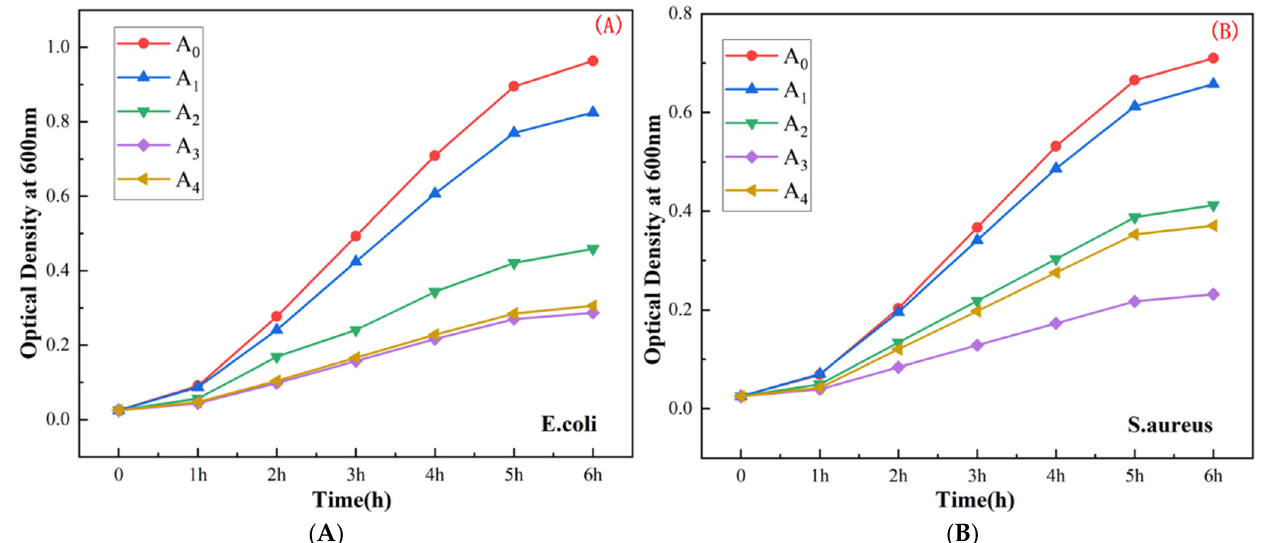
Figure 10. Growth curves for ( A ) E. coli and ( B ) S. aureus.